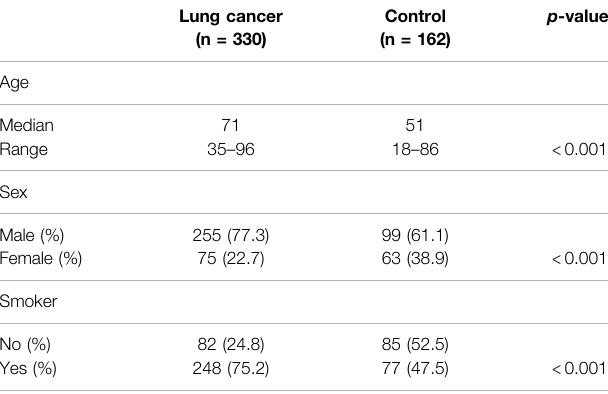
TABLE 1 | Demographic characteristics of the study participants.